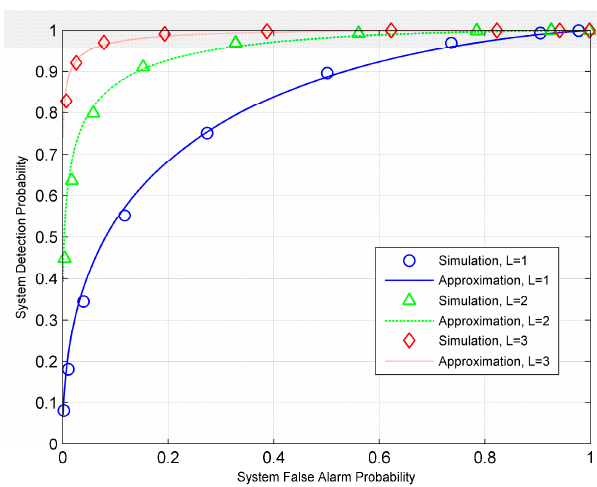
Figure 6. ROC curves for the ED fusion rule with K = 100.